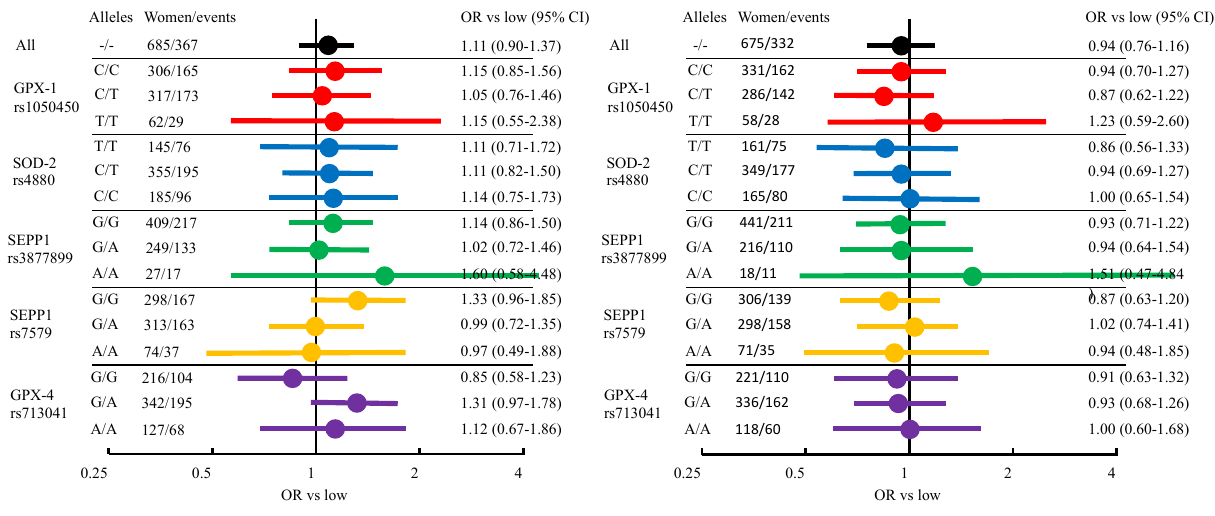
Figure 4. Forest plot of age adjusted odds ratios (ORs) for serum selenium tertiles and breast cancer risk. Each color represent results stratified for different SNPs.